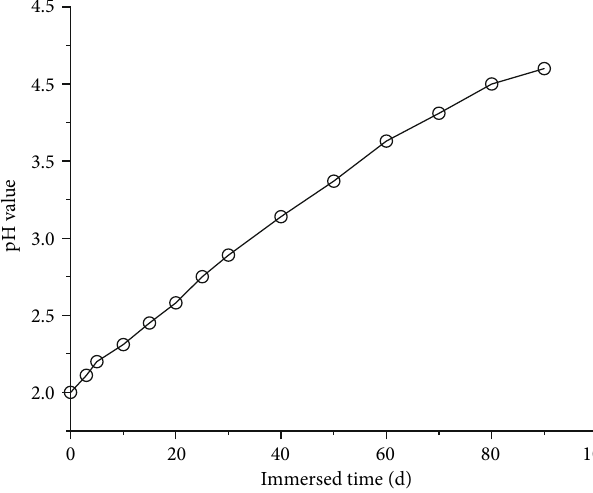
Figure 3: Variation curve of the pH value with the change of immersed